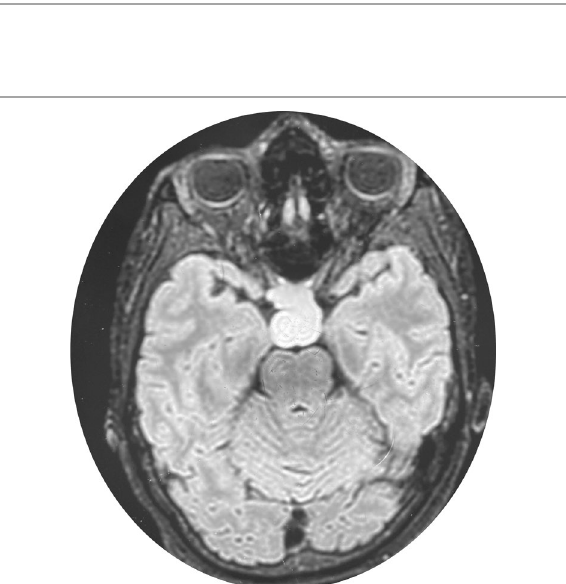
Fig. 4 MRI brain flair sequence showing the hyperintense suprasellar